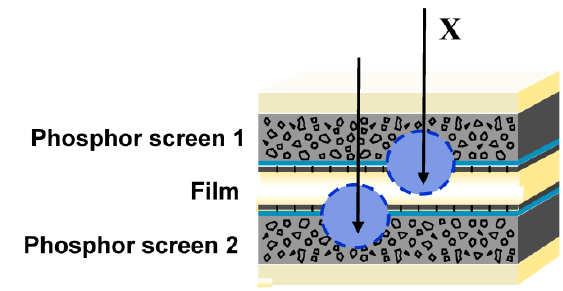
Figure 1. Screen / film detector, used in conventional